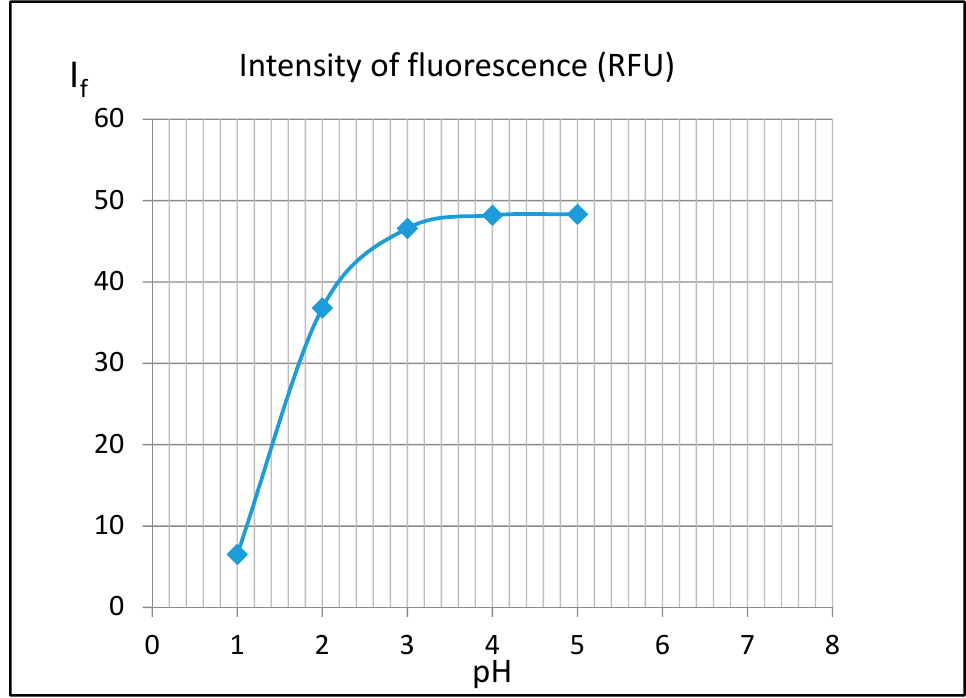
Figure 10. Relationship between fluorescence intensity I f of 3-aminoflavone and pH. For excitation and emission, filters with wavelengths of 350 nm and 470 nm were used, respectively.